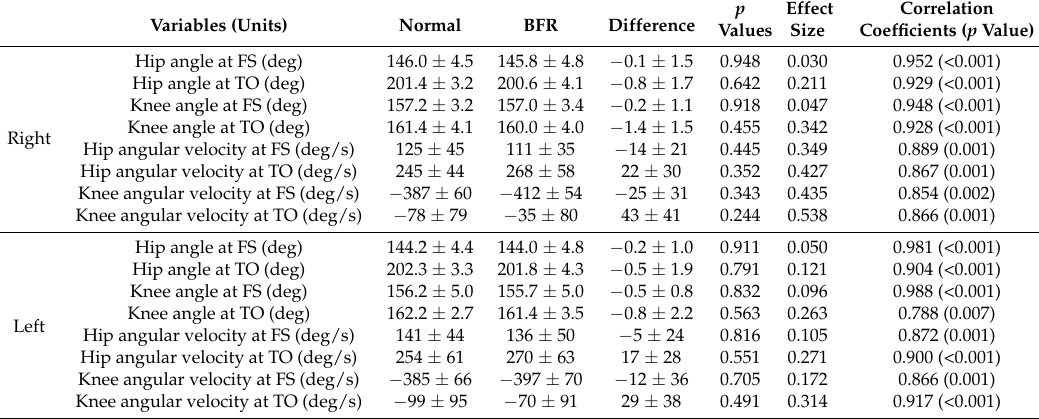
Table 2. Hip and knee joint angles and angular velocities at the foot strike (FS) and toe-off (TO) and corresponding difference, p -value of a t -test, effect size (Cohen’s d), and correlation coefficients between normal and BFR conditions.